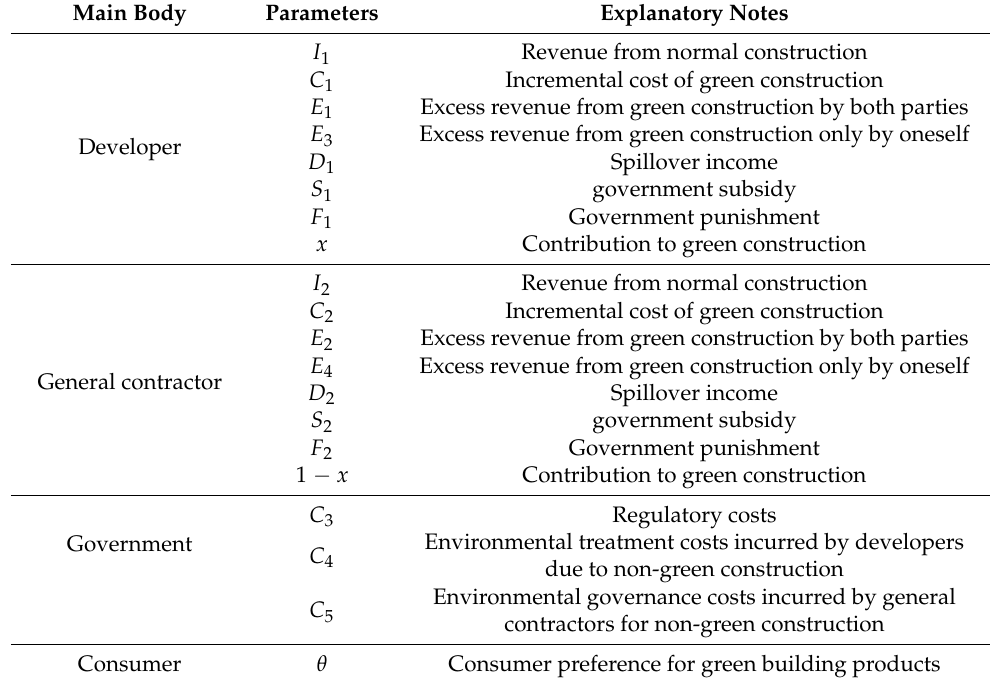
Table 1. Main body parameters.